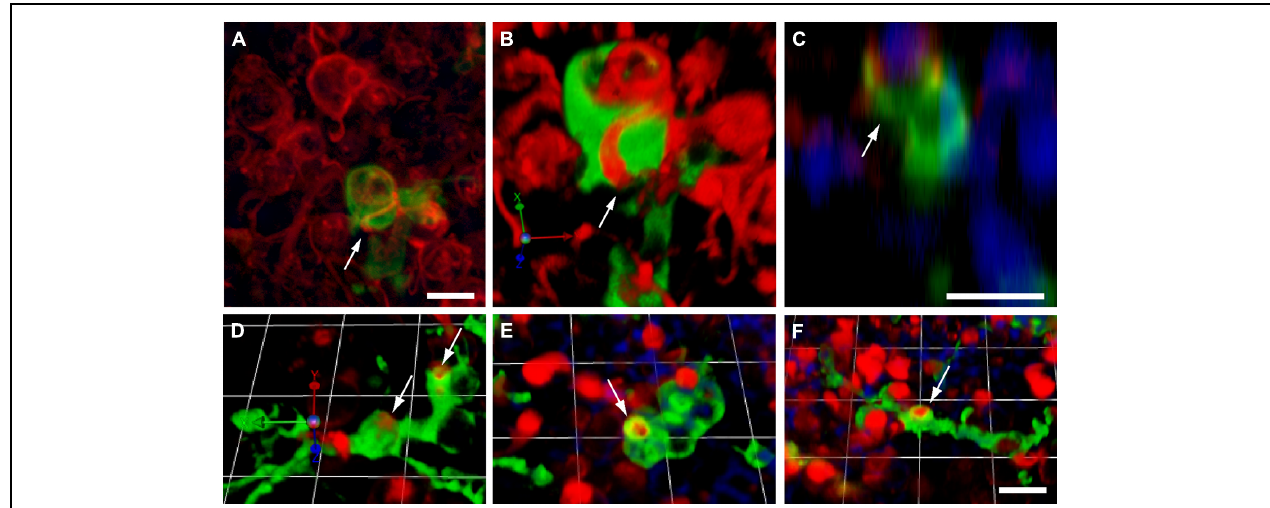
FIGURE 6 | Macrophage engulfment of hair cell debris. Confocal images of labeled hair cells and macrophages often revealed hair cells that were apparently enclosed within the processes of macrophages (arrows). (A–C) Three different renderings of the same confocal stack, showing an otoferlin-labeled hair cell (red) being engulfed by a calyx-like phagocytic process of a GFP-expressing macrophage (green). (A) : Maxi- mum intensity projection. (B) 3-D rendering of same image stack,